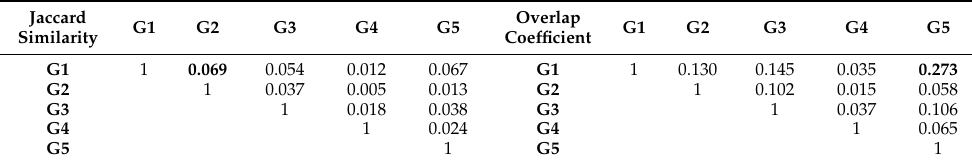
Table 4. Jaccard and overlap coefficient similarities of the